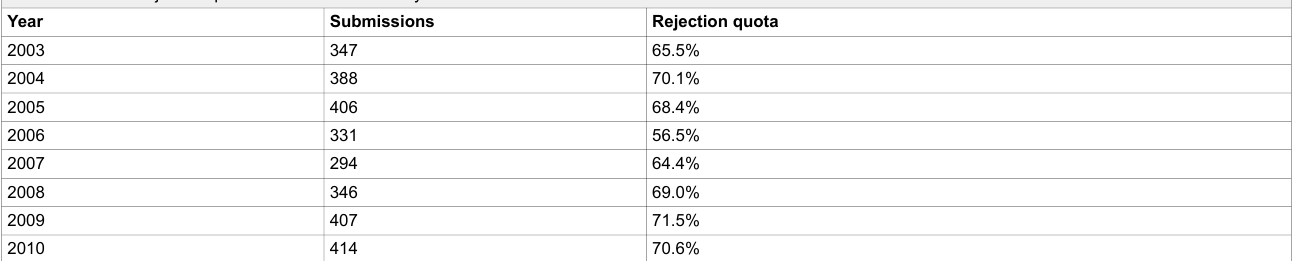
Table 1 Submissions and rejection quota Swiss Medical